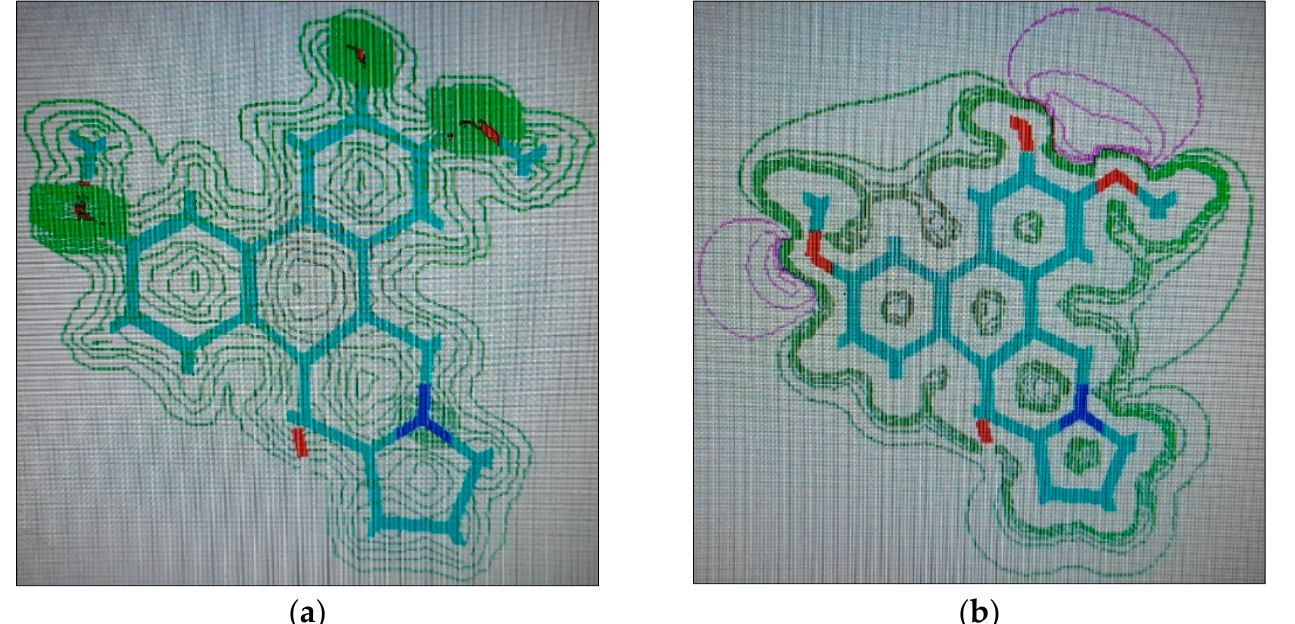
Figure 8. Structure ( 5 ) (tylophorinidine), 2D renderings: ( a ) charge density localizations; ( b ) electrostatic potential.